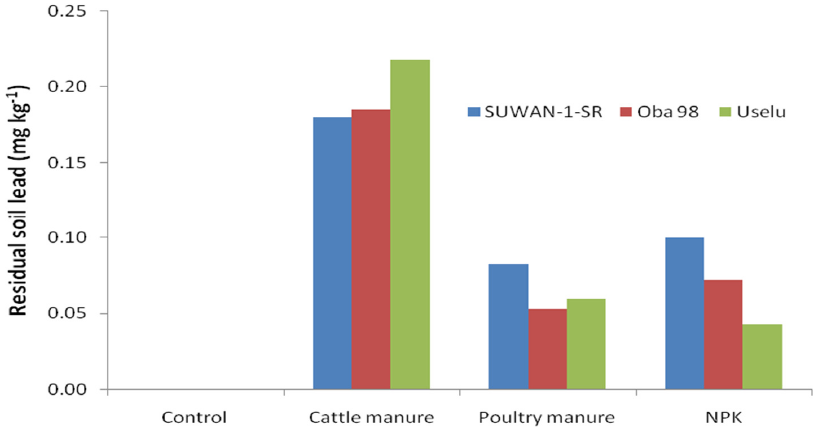
Figure 5. Interaction of maize variety and soil amendment on residual soil lead